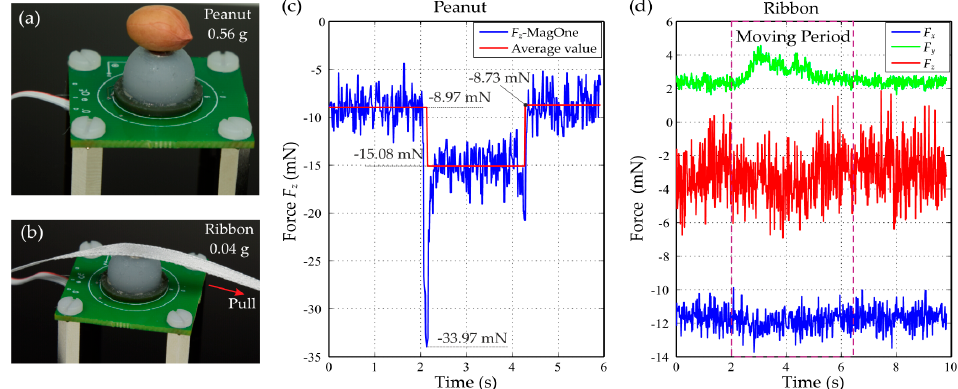
Figure 16. Demonstrations: ( a ) A photograph of the MagOne with a peanut on top; ( b ) A photograph of the MagOne with a ribbon; ( c ) Normal force output F z during drop down and pick up; ( d ) The three-axis force output when pulling a soft, thin ribbon across the top surface of MagOne along the y axis.